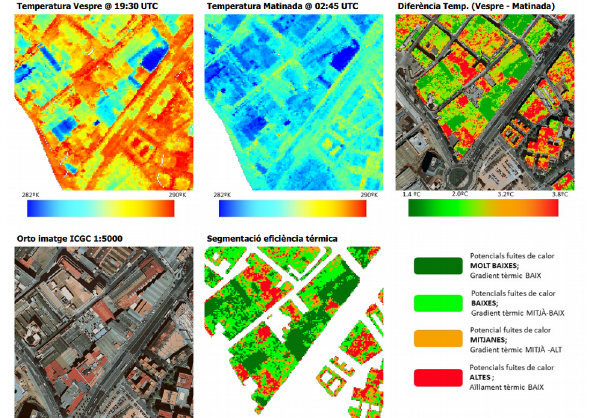
Figure 7. Top left: thermal image at night. top centre: thermal image early in the morning, top right: temperature gradient at rooftop, bottom left: orthoimage, bottom centre: temperature gradient segmentation and bottom right: legend.